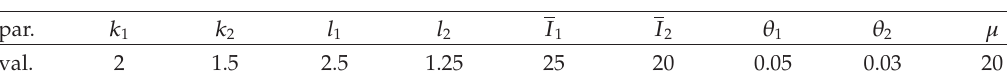
par. k 1 k 2 l 1 l 2 I 1 I 2 θ 1 θ 2